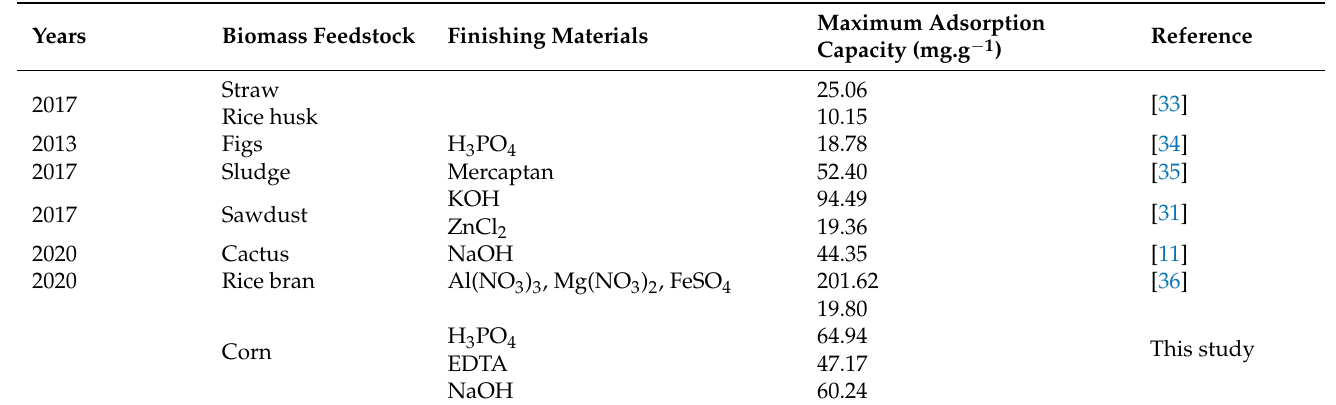
Table 8. Comparison of various representative Ni(II) adsorbents.